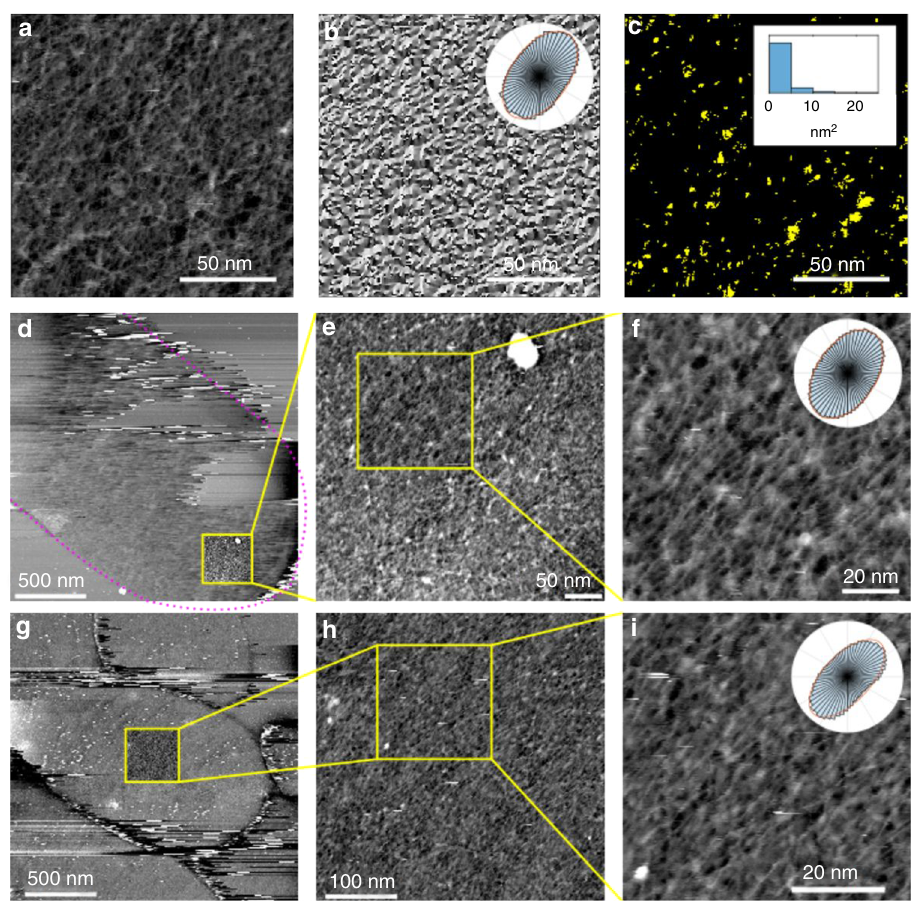
Fig. 2 Mapping and quanti fi cation of glycan chain arrangement. a Example AFM image data. b Gradient orientation map of a . Inset: Polar histogram of data shown in b , overlaid with fi tted ellipse. Dividing the long axis of the ellipse by the short yields a dimensionless parameter which re fl ects orientation order, with a higher number indicating an increased tendency to order. c Location of pores identi fi ed in the example image a . Inset: distribution of pore areas. d Peptidoglycan at pole: Large scan with bacterial shape outlined (dotted line). The instability inherent in imaging overlapping polymer lea fl ets is apparent in the top half of the image (height range 20 nm). e Smaller scan (acquired subsequently at lower scan speed) of region marked in d (height range 4 nm). f Enlargement of region marked in e . Many glycan strands running approximately along the circumferential axis of the cell are clearly visible (height range 3.5 nm). Inset: polar histogram. g Peptidoglycan from cylinder: Large scan of a different sacculus to d (height range 7.5 nm). h Smaller scan (acquired subsequently at lower scan speed) of region marked in g (height range 4 nm). i Enlargement of region marked in h . Many glycan strands running approximately along the circumferential axis of the cell are clearly visible (height range 4 nm). Inset: polar